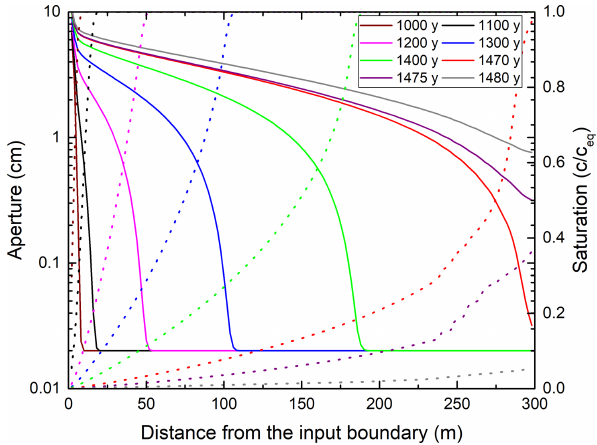
Figure 9. Evolution of total flow through the network (full red line), input flow into the seeded wormhole (dashed), and length of the wormhole (blue line).